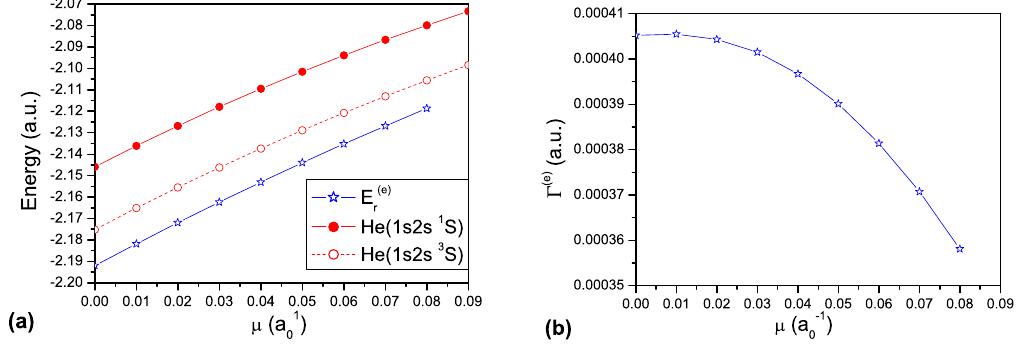
( e ) − − He ( 1 s 2 s 2 ) system for r in e